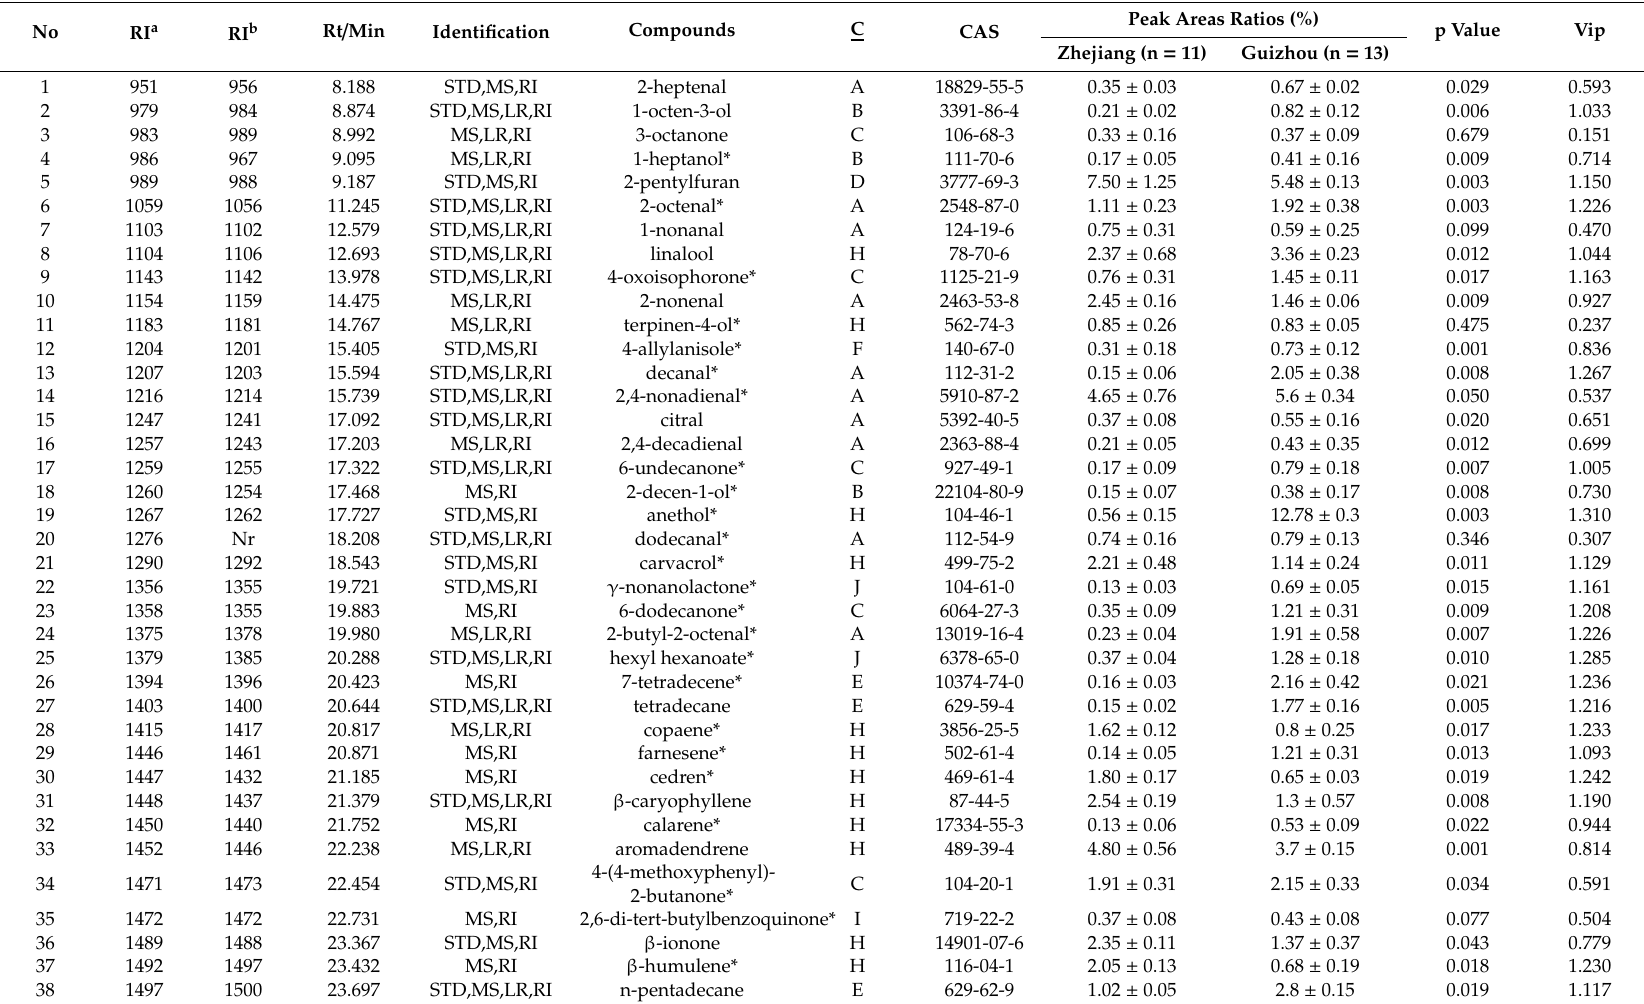
Table 2. Relative contents (%) of volatile oil of Selaginella doederleinii by HS-SPME /